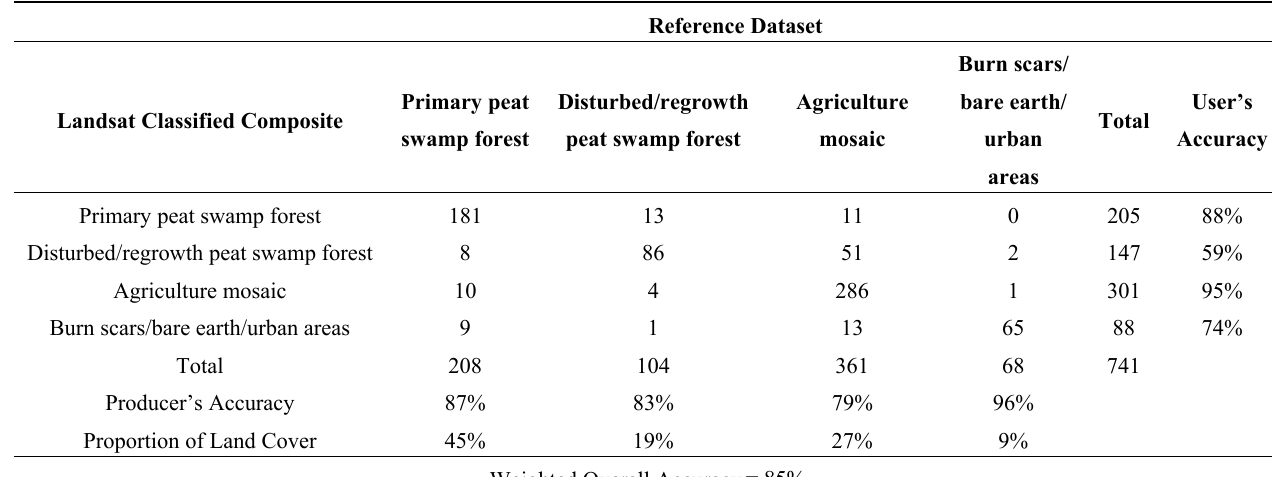
Table 3. Confusion matrix for 2005 peat swamp forest-cover composite in Sundaland.